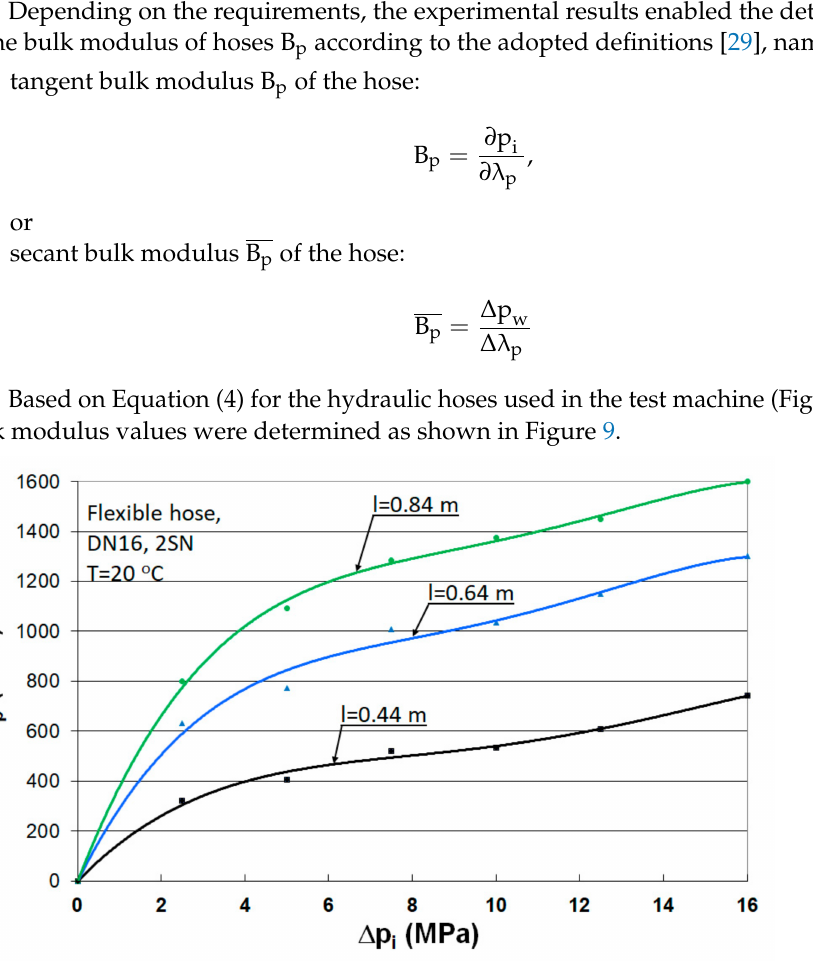
Figure 9. Dependence of the bulk modulus B p of hydraulic hoses 2SN, with d = 16 mm used in the steering mechanism of the test machine vs. internal pressure ∆ p i for various hose lengths l p